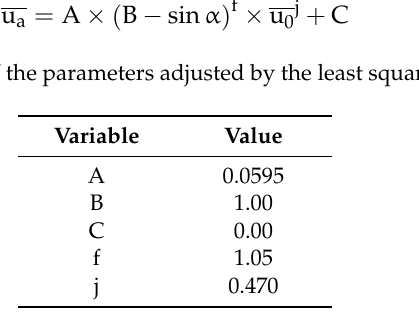
Table 4. Results of the parameters adjusted by the least squares method. Figure 10. Linear regression between average velocity at the opening and u (cid:2868) (cid:3364)(cid:3364)(cid:3364) (cid:2868).(cid:2873) (cid:4666)1 (cid:3398) sinα(cid:4667) .